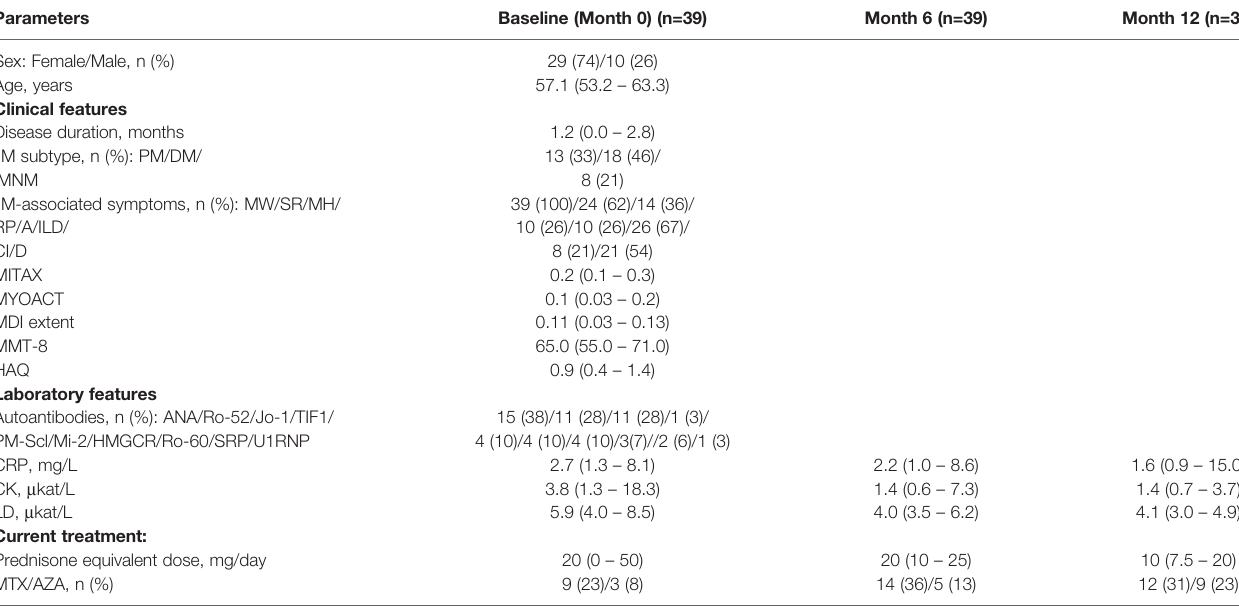
TABLE 2 | Baseline clinical characteristics of treatment-naïve and early-disease IIM patients treated with standard-of-care pharmacological therapy: longitudinal cohort 1.